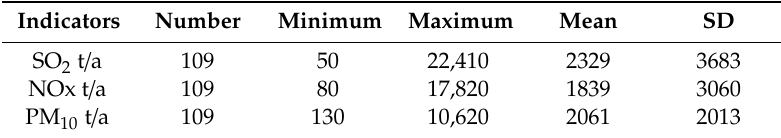
Table 1. Descriptive statistics of the air pollutants.